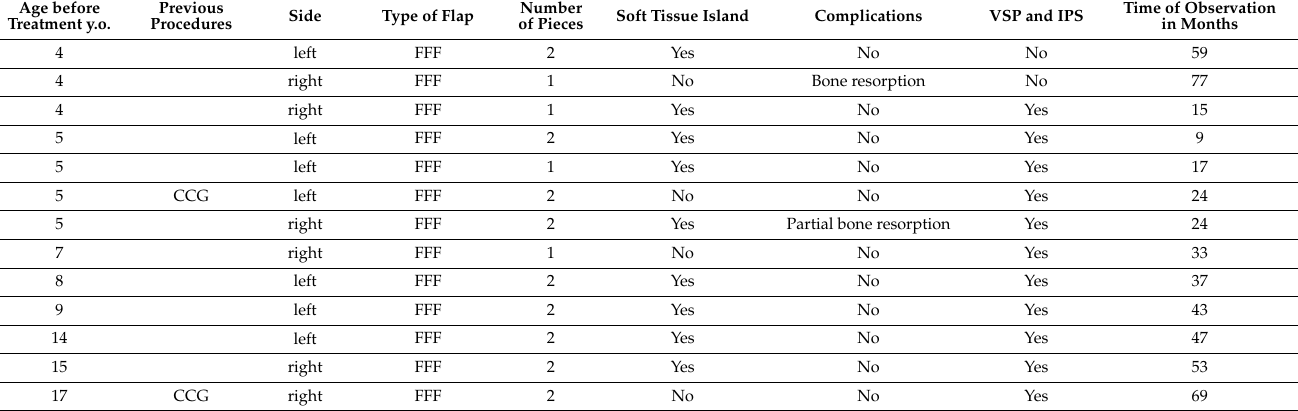
bone fragment. In four patients, an additional unilateral sagittal split osteotomy was